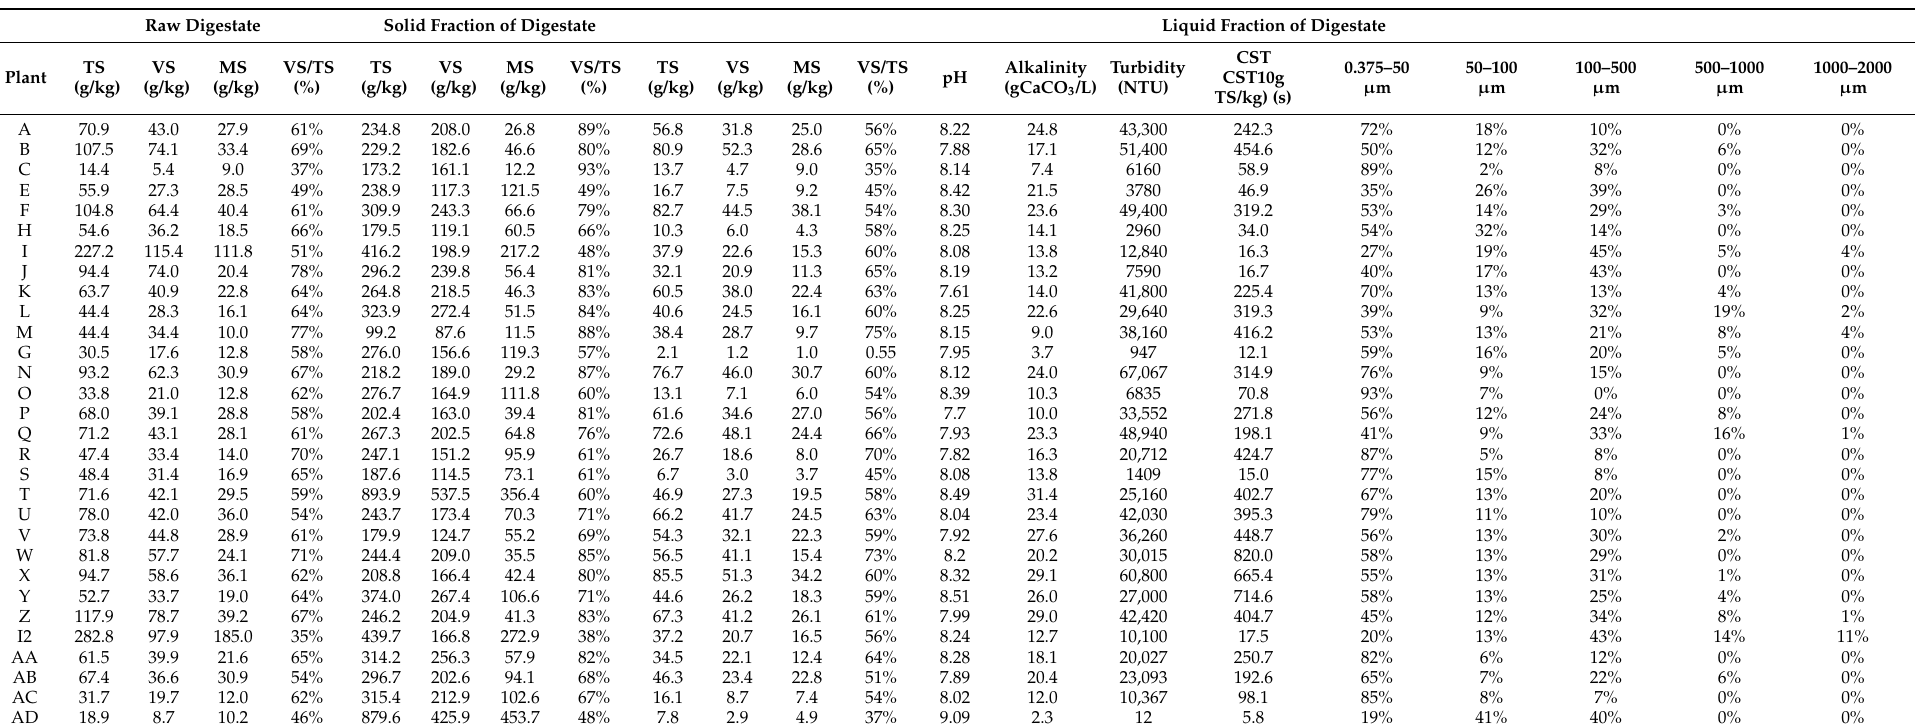
Table A2. Total solids (TS), volatile solids (VS) and mineral solids (MS), VS/TS, pH, alkalinity, turbidity, capillary suction time (CST) and particle